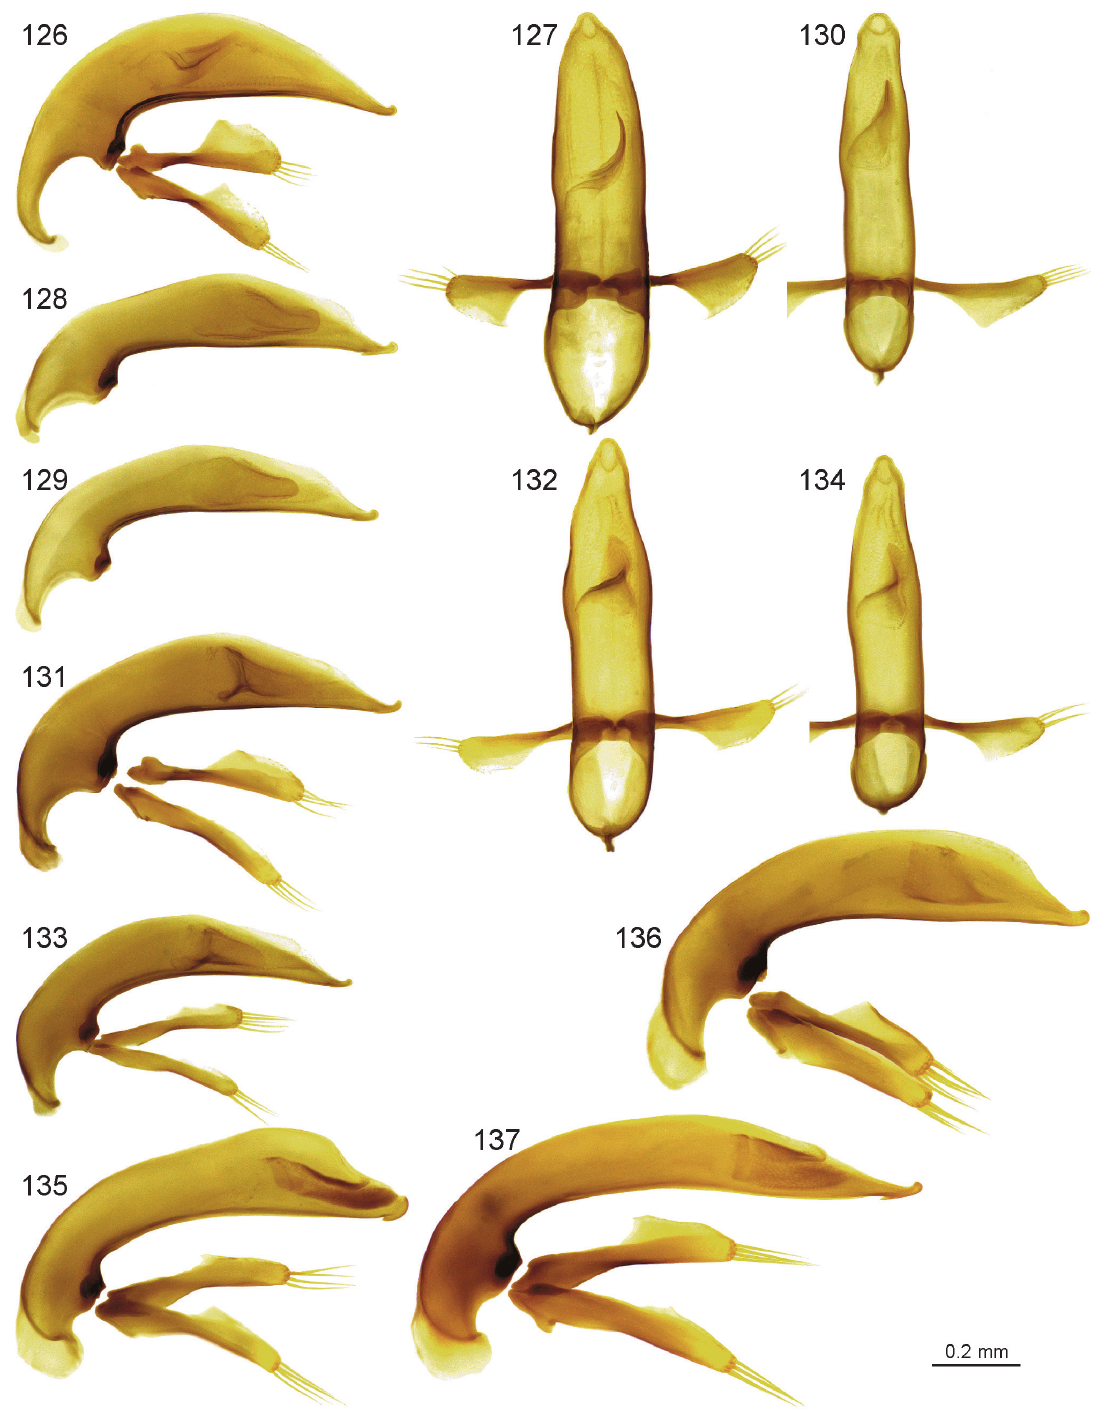
Figs 126–137. Trechus spp., aedeagal median lobe, left lateral view (126, 128–129, 131, 133, 135–137) and dorsal view (127, 130, 132, 134). 126–127 . T. sanettii sp. nov., paratypes. 128 . T.